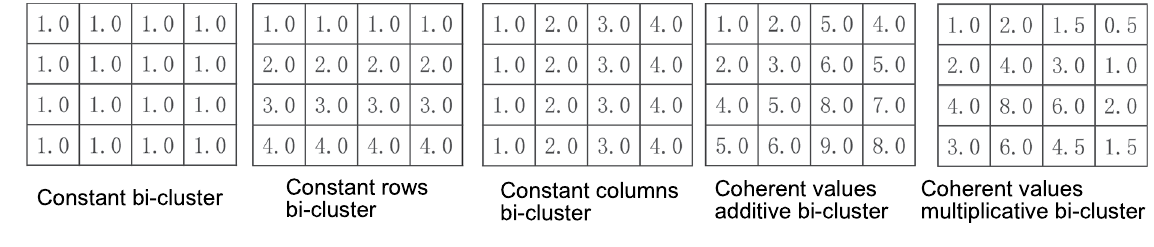
Figure 11. Example of the five types of